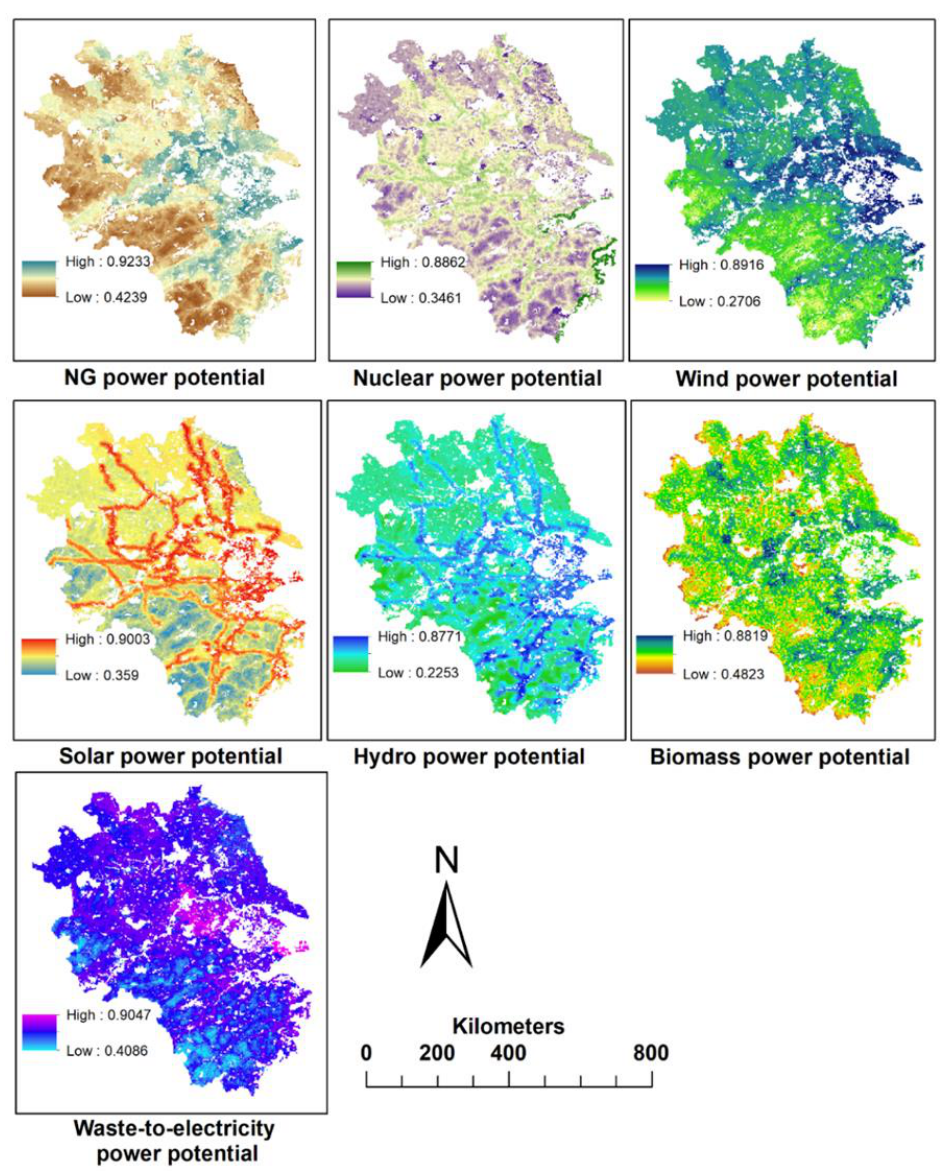
Figure 7. Spatial siting potential map of alternative power plants.